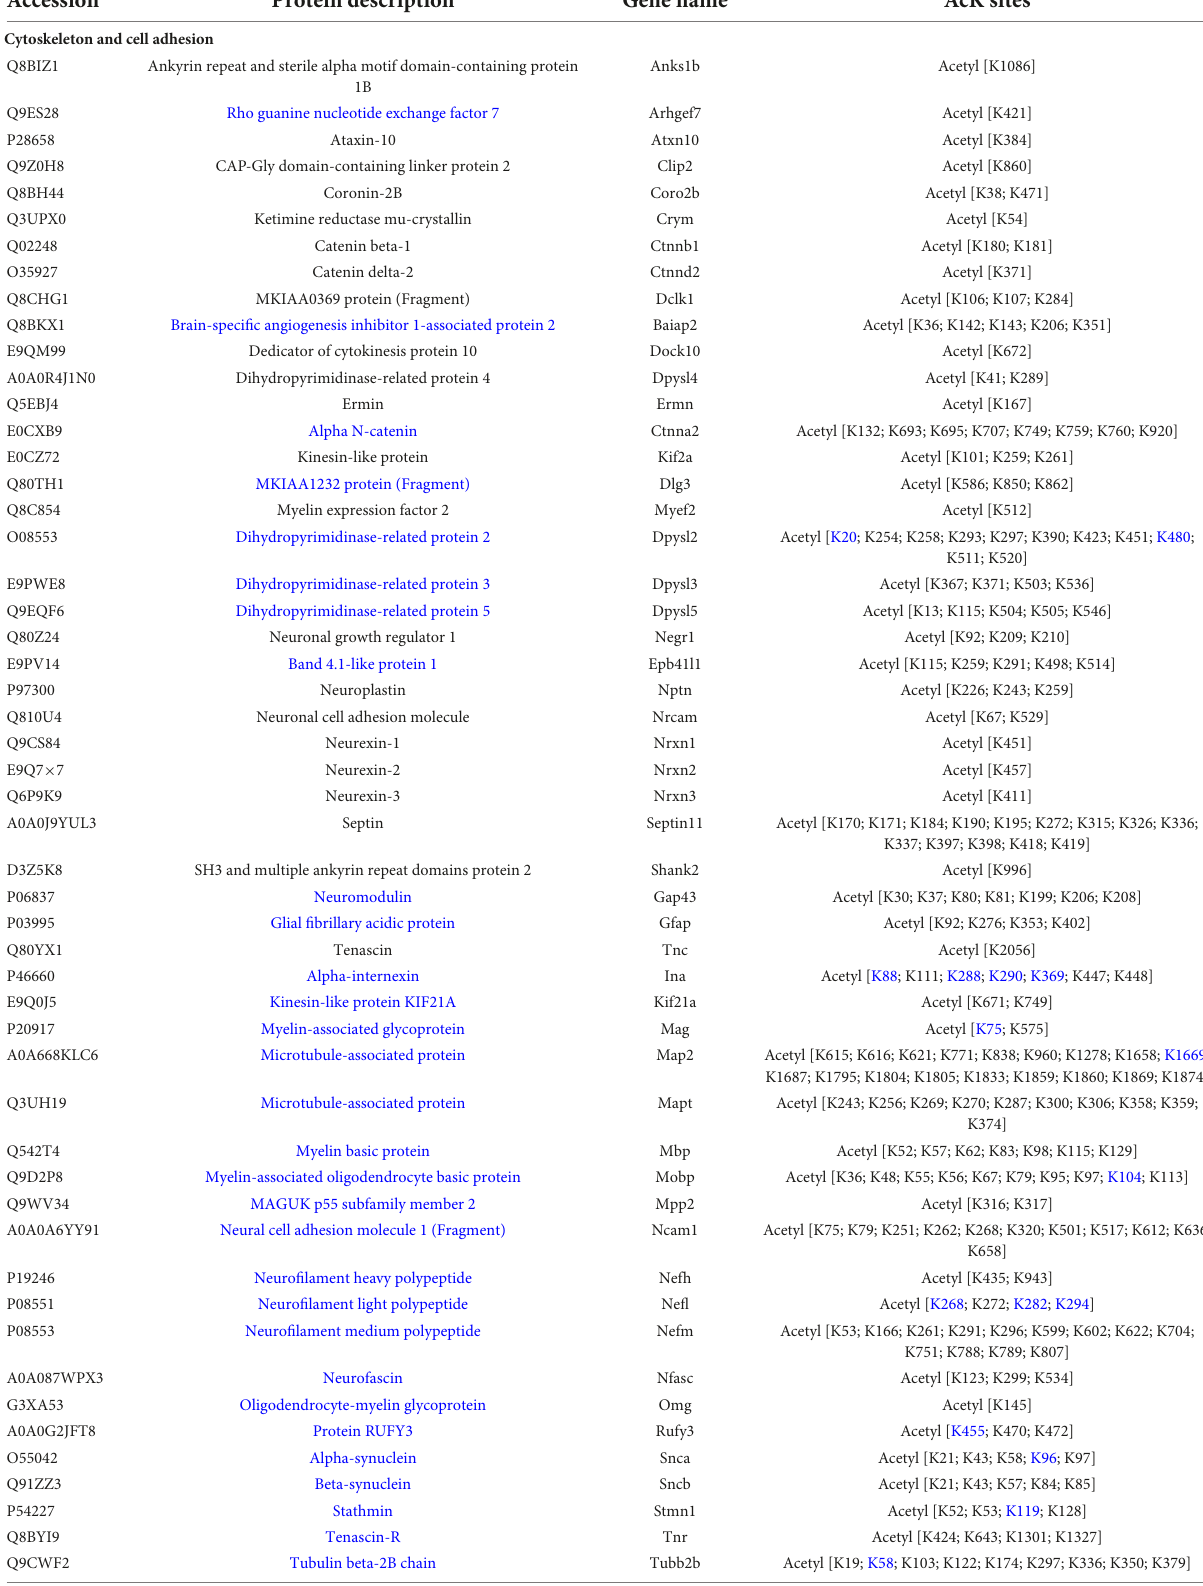
TABLE 2 The acetylated modified brain-specific or enriched